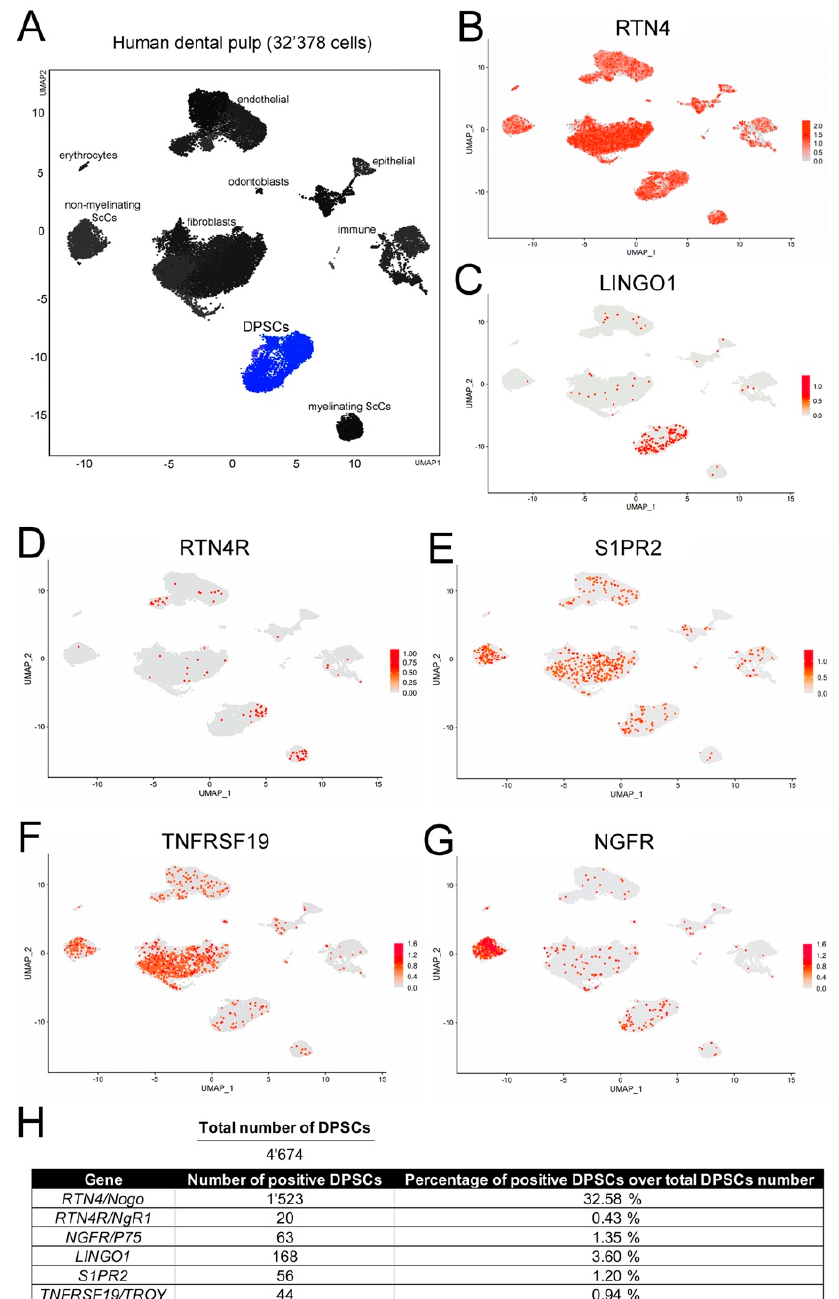
Figure 3. Feature plots showing the expression of NOGO and NOGO -related receptors genes in the dental pulp stem cell compartment of human adult teeth. ( A ) Specific cell clusters within the dental pulp. In blue the DPSCs cluster. ( B – G ) Cells expressing RTN4 ( NOGO ; ( B )), LINGO1 ( C ), RTN4R ( D ), S1PR2 ( E ), TNFRF19 ( F ), and NGFR ( G ) in all dental pulp compartments. Expression in individual cells is represented by red dots. ( H ) Quantitative details of the NOGO and NOGO -related receptors genes within DPSCs cluster.